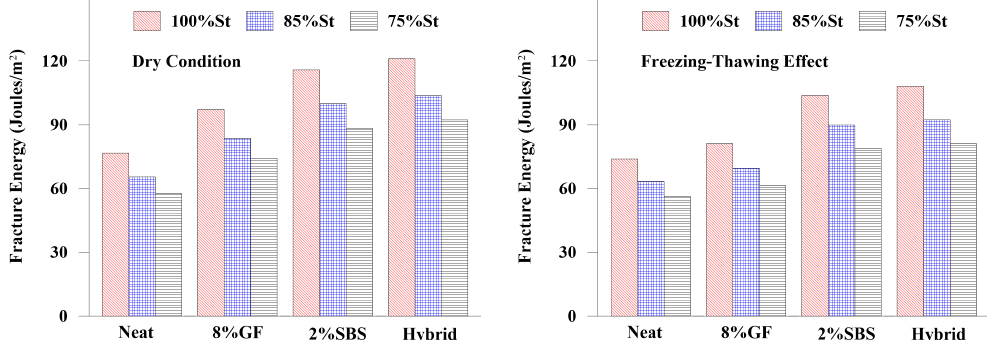
Figure 17. Influence of additives on the asphalt mix’s fracture